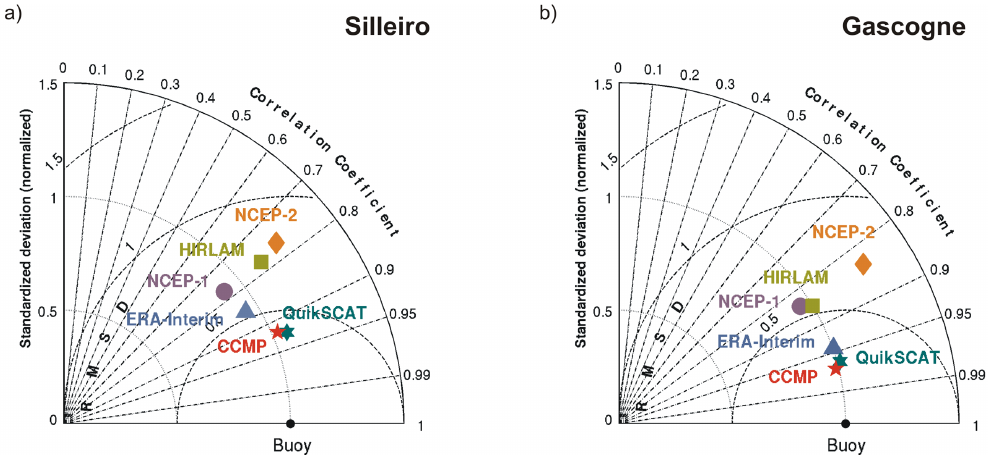
Fig. 2. Taylor diagrams showing the comparison of various wind products and anemometer winds at the Silleiro and Gascogne buoys. The diagram is constructed in terms of the correlation among time series, their centered root-mean-square (rms) difference and the standard deviation ( σ) normalized by the amplitude of the